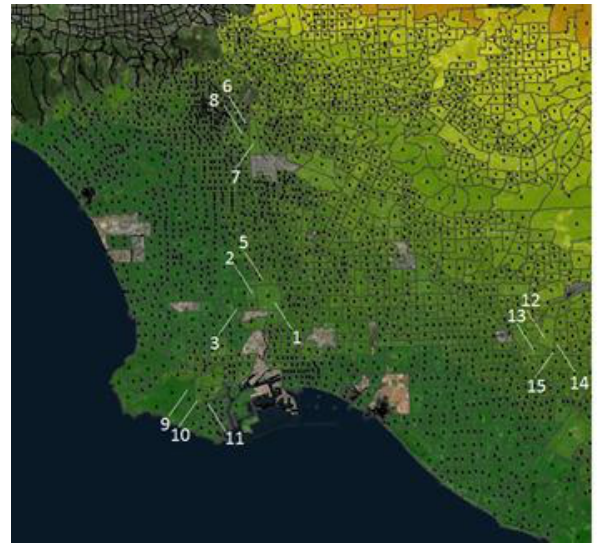
Figure 6. UHII in west Los Angeles Basin. Numbers indicate example census tracts listed in Table 2 and discussed in this section. Table 2. Random samples (microclimate variations) in west Los Angeles Basin. (see Figure 6 for tract locations).